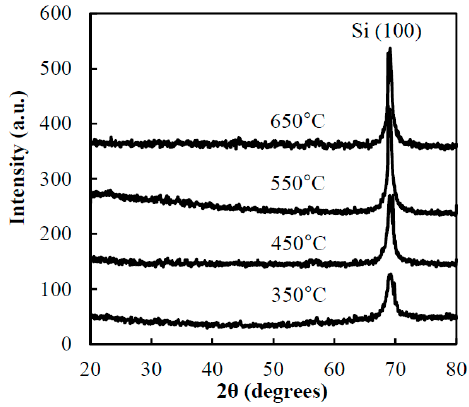
Figure 1. XRD patterns of the Al 2 O 3 films annealed at various temperatures.